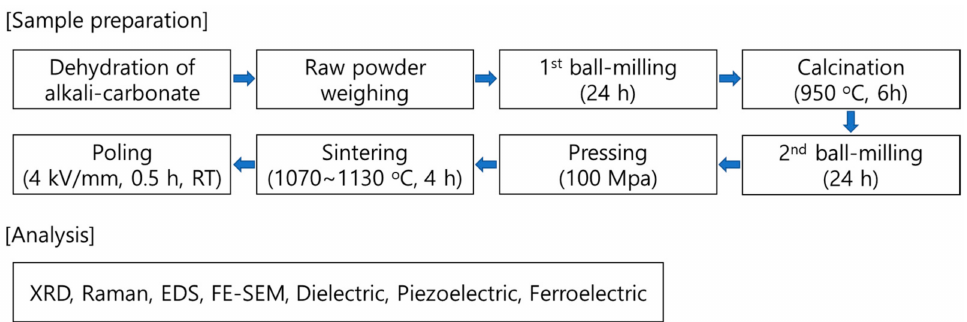
Scheme 1. Schematic diagram of the experimental procedure in this